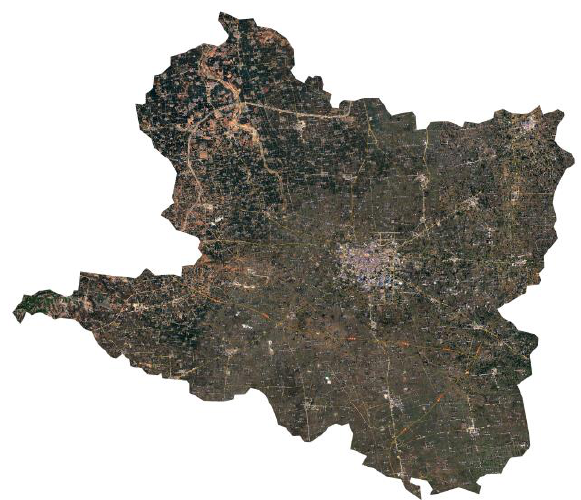
Figure 6. Remote sensing image of Dengzhou city in 2015.